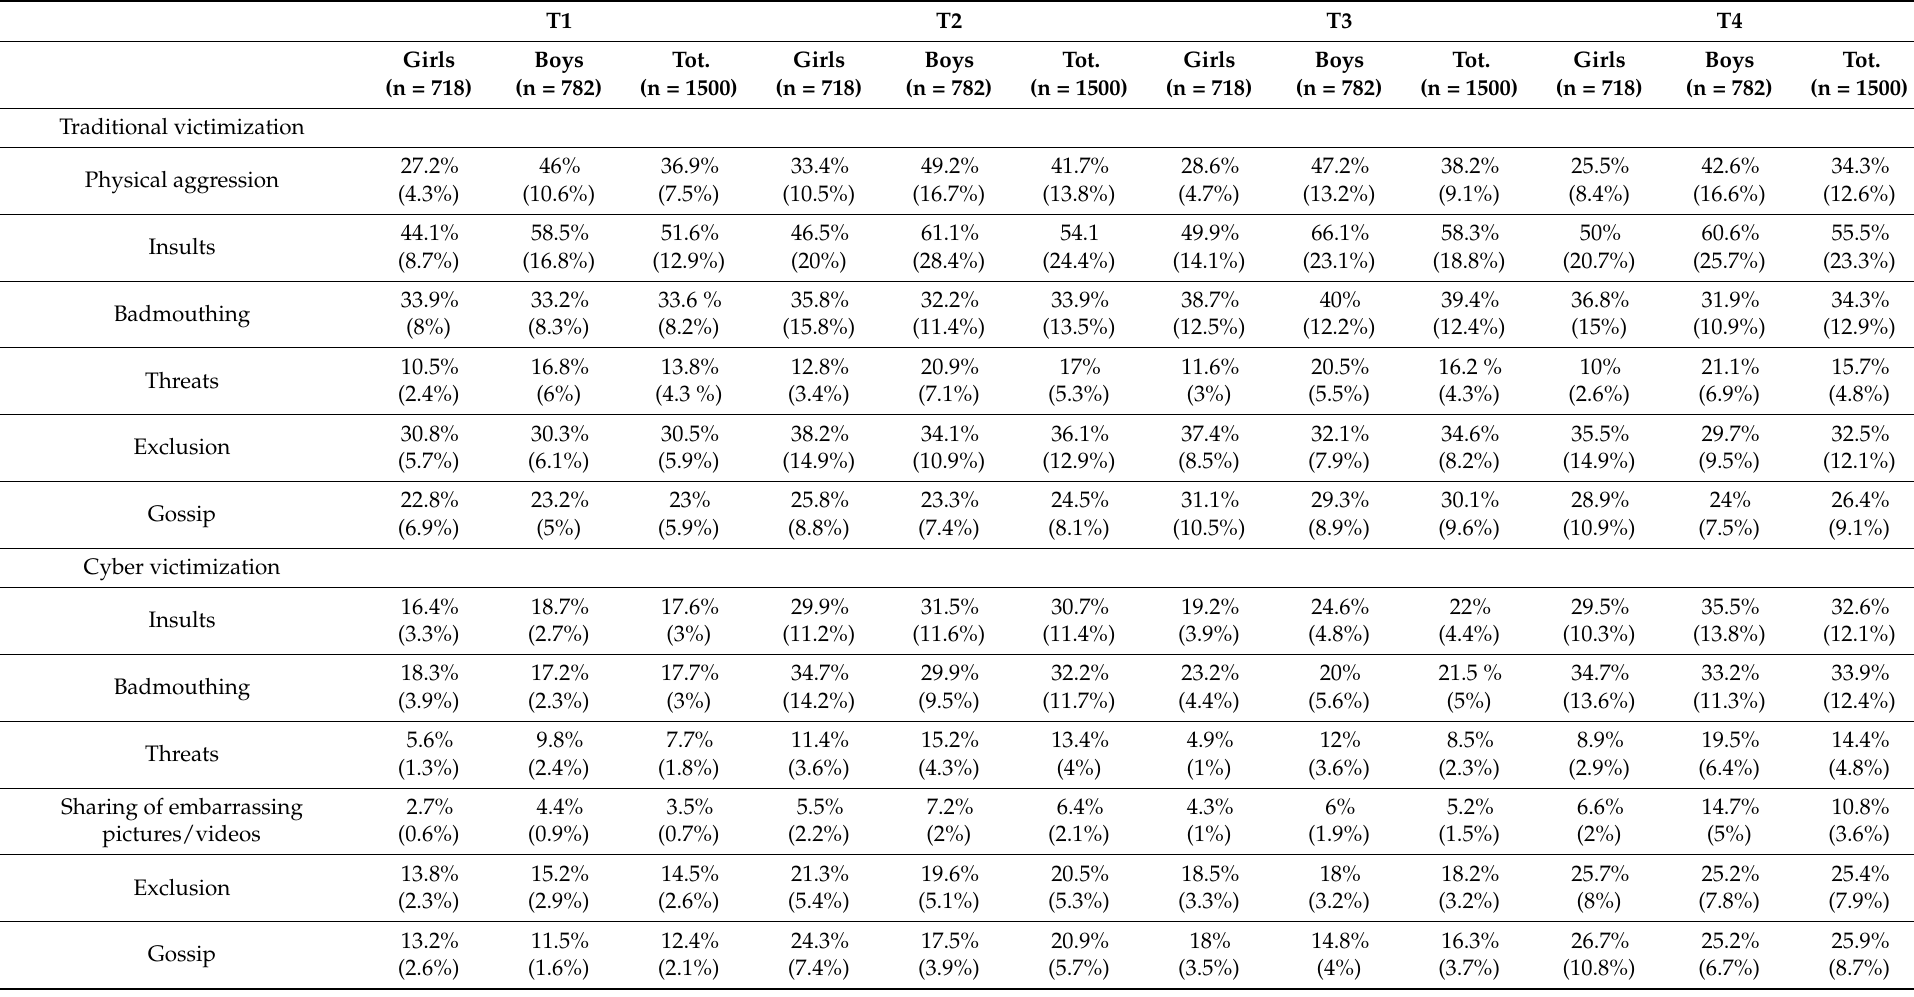
Table 2. Percentages of adolescents reporting different types of victimization. Frequent victimization (“sometimes” or “often”) is reported in